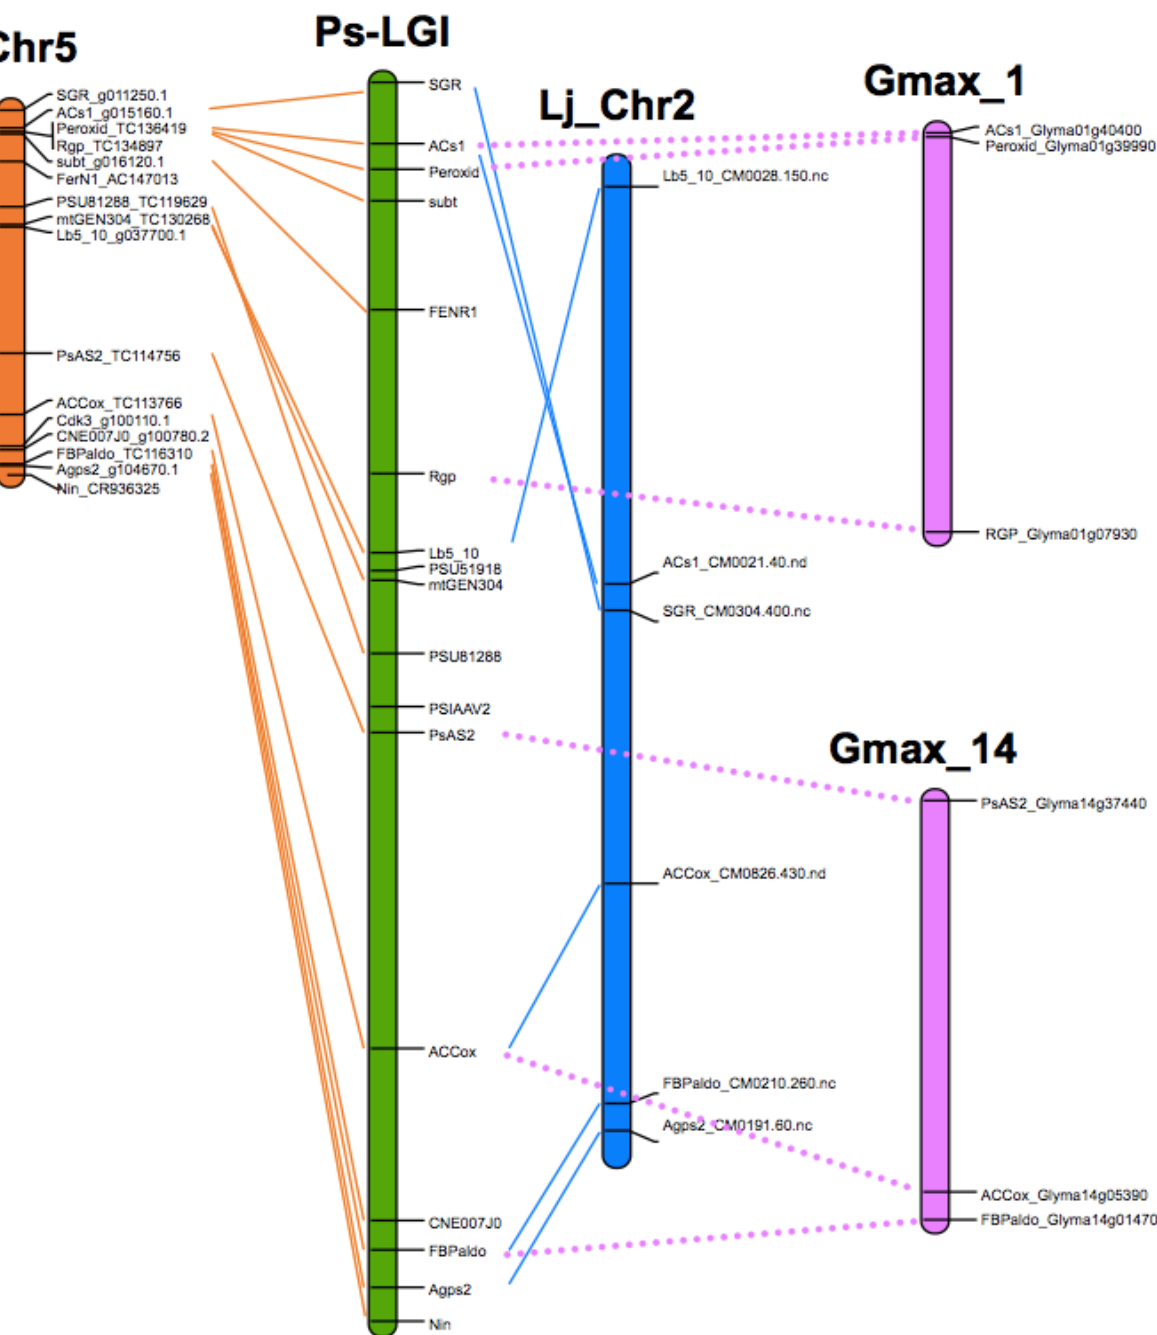
Figure 3. Comparative maps of P. sativum and M. truncatula , L. japonicus , soybean for LGI, as an example of synteny conservation among legume